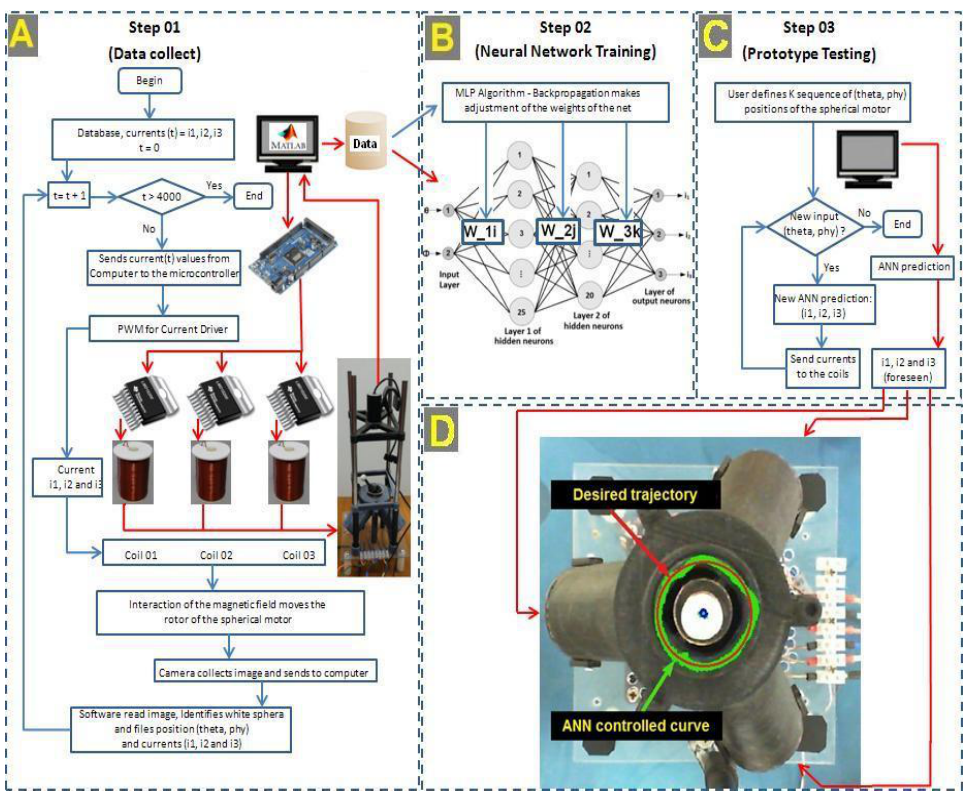
Figure 9. ( A ) Data collection step; ( B ) neural network training; ( C ) prototype testing step; and ( D ) typical learning curves of the MLP(2,25,20,3) network for different sizes of the training